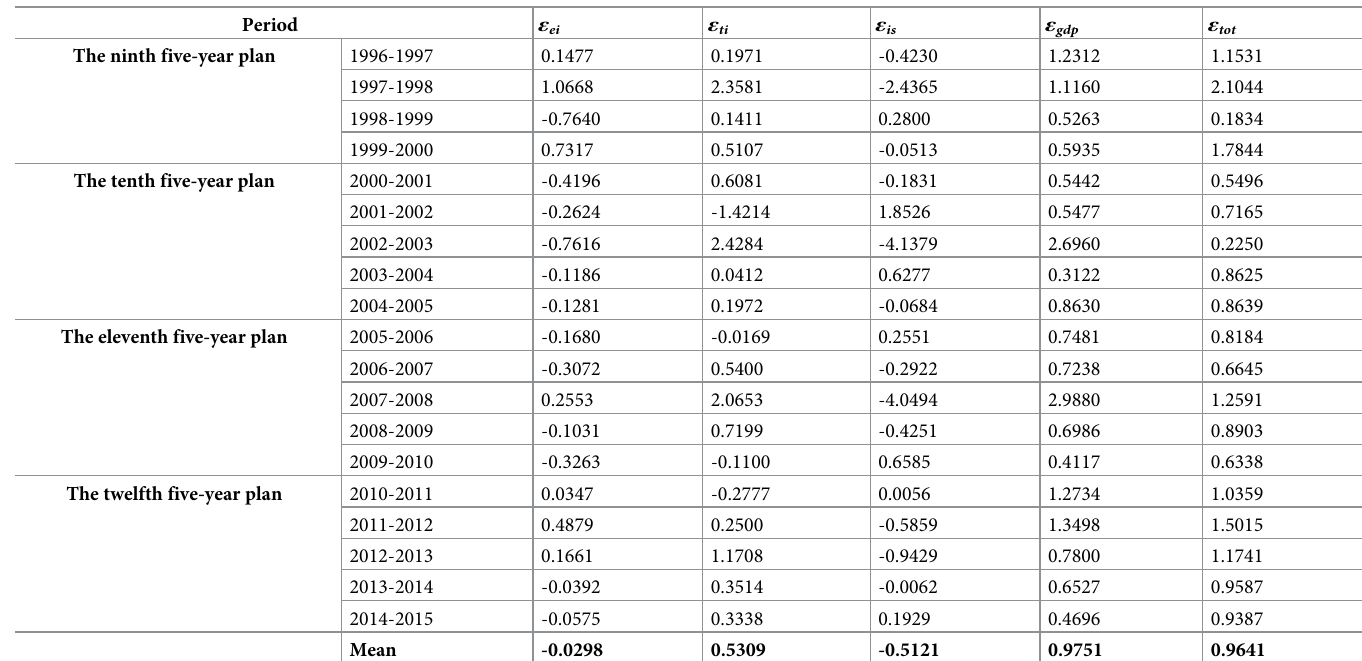
Table 5. Decoupling index and the influencing factors.